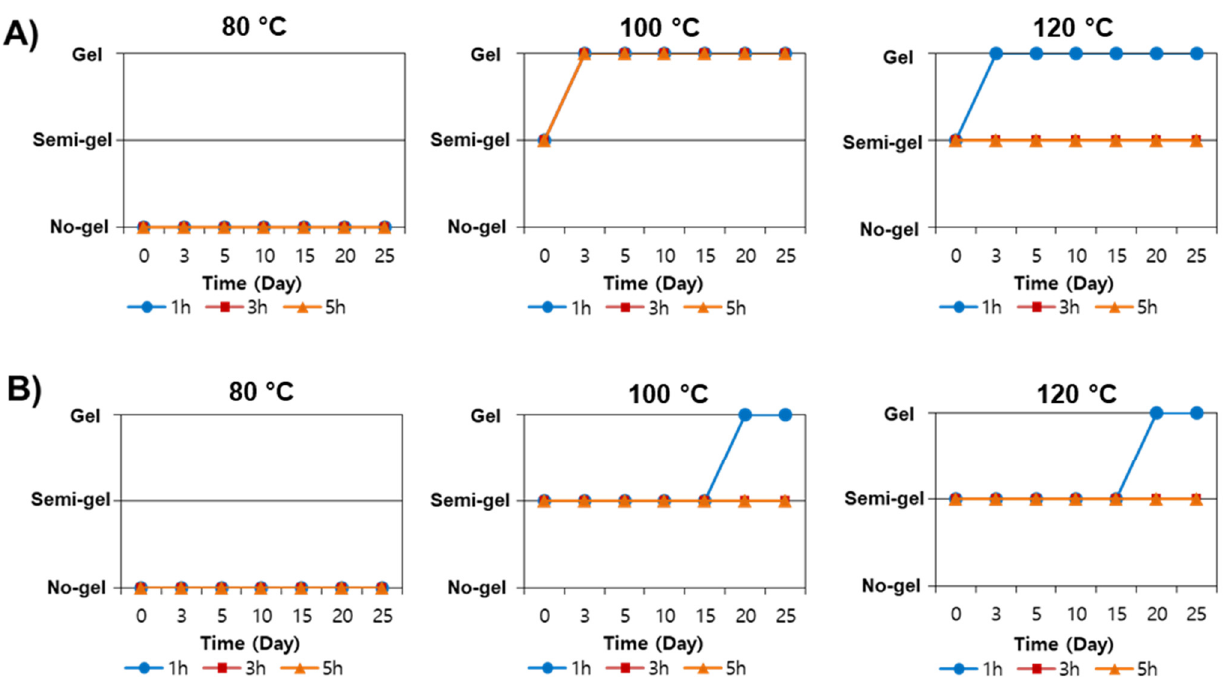
Figure 7. Gelation time of SS at 4 °C with different extraction conditions. ( A ) The gelation status of SS was obtained from water and 5–10% EtOH. ( B ) The gelation status of SS was obtained from 5–10% glycine.